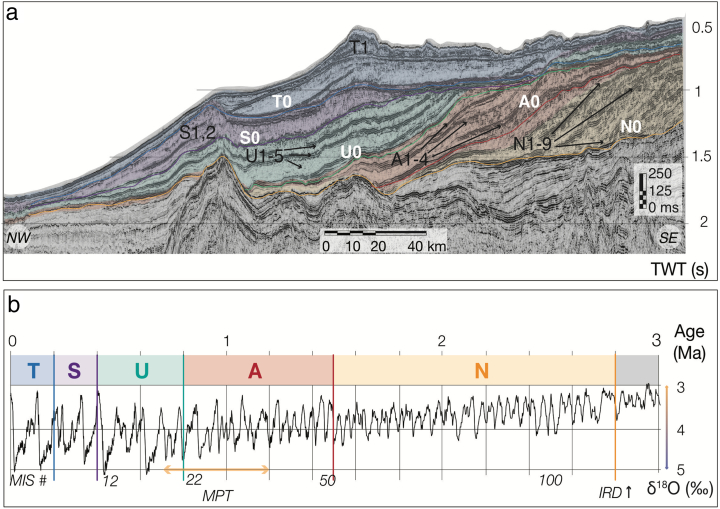
Naust Formation chronostratigraphy. a. Dip seismic profile GMNR94–106 showing Naust sequences (located in Fig. 1b). N0 represents the basal Naust surface. b. Approximate chronology of the Naust Formation evolution (from Rise et al., 2010) with the δ18O marine-isotope time series as a global ice volume proxy (from Lisiecki and Raymo, 2005). Major events are annotated to the left: IRD – early Quaternary increase in ice-rafted debris (Jansen and Sjøholm, 1991). MPT – the middle-Pleistocene Transition (~ 1.2–0.75 Ma) (Clark et al., 2006). Modified from Montelli et al. (2017).